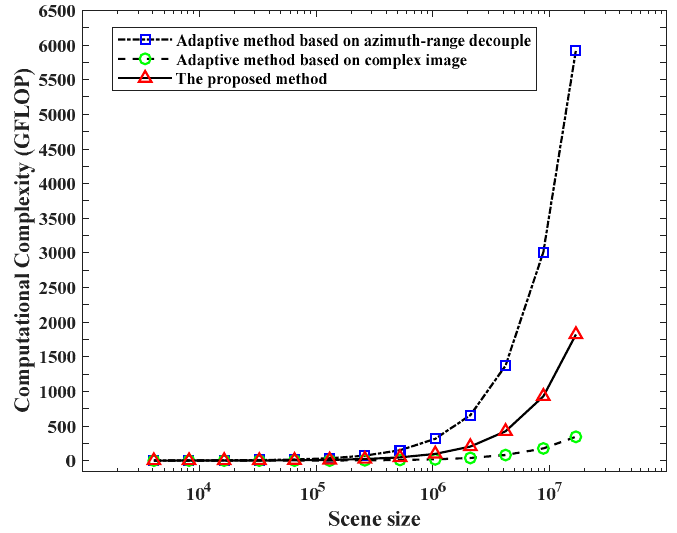
ff erent parameter estimation